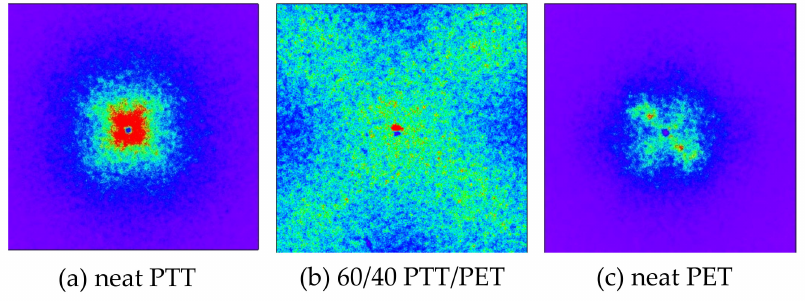
Figure 3. Hv light scattering patterns of ( a ) neat PTT, ( b ) 60 / 40 PTT / PET and ( c ) neat PET obtained by isothermal annealing at 180 ◦ C.